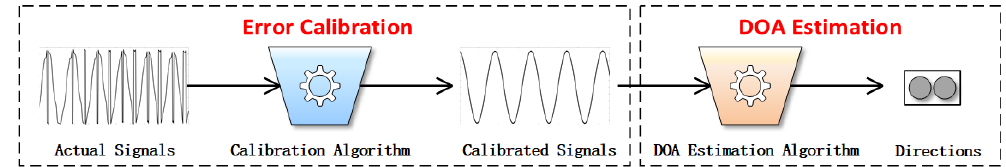
Figure 1. Traditional error calibration